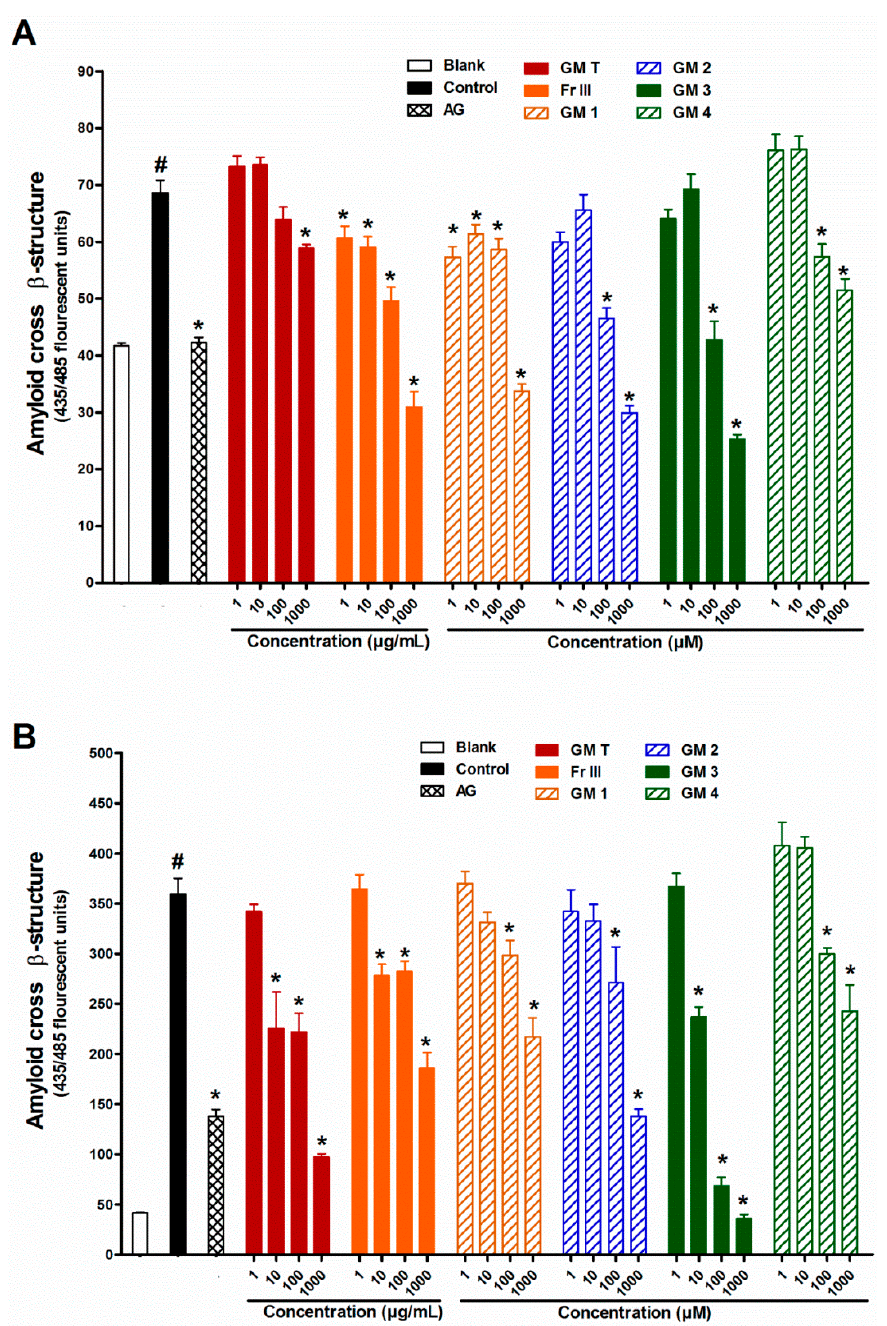
Figure 5. Effect of GMT, Fr III and isolated compounds on amyloid cross β -structure levels when BSA incubated with glucose ( A ), and ribose ( B ) at week 4. Blank is a reaction mixture including BSA and glucose or ribose kept at − 20 °C while control is the same reaction mixture but incubated at 37 °C. AG was used as standard anti AGEs drug. Results are expressed as mean ± SEM ( n = 3). # p < 0.05 when compared to Blank, * p < 0.05 when compared to Control.